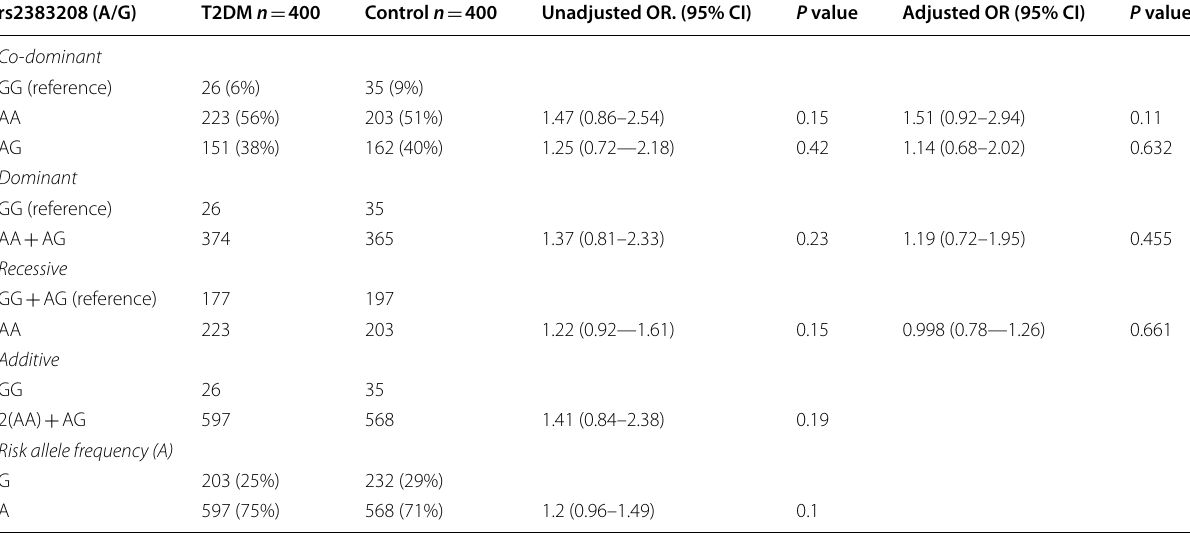
Table 3 Distribution of genotypes and allele frequency in CDKN2A/B gene polymorphism (rs2383208) for T2DM and control subjects rs2383208 (A/G) T2DM n =